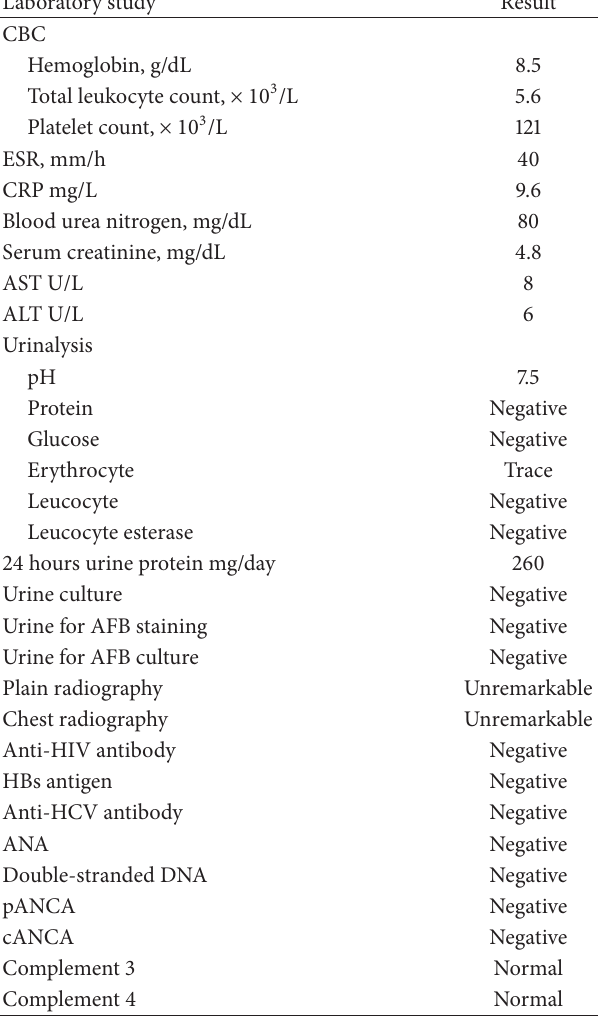
Table 1: Laboratory studies ∗ .